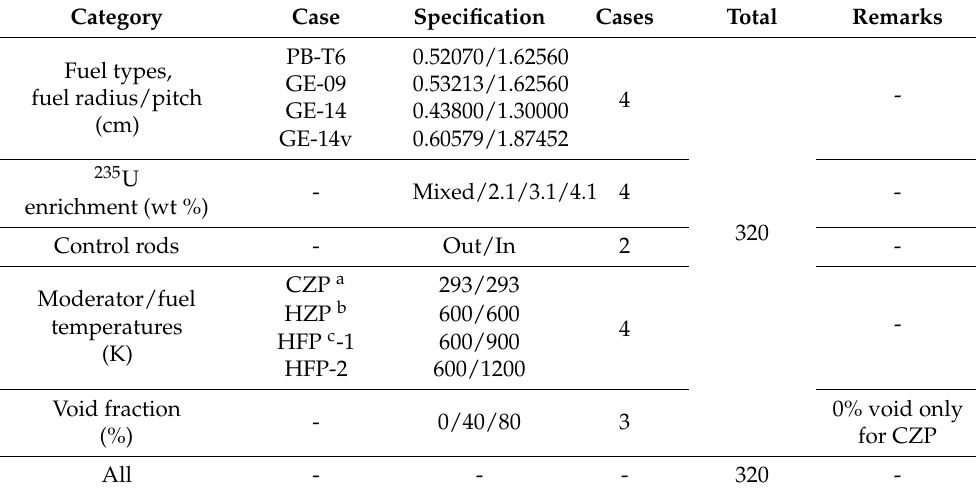
Table 4. Benchmark cases for the BWR single